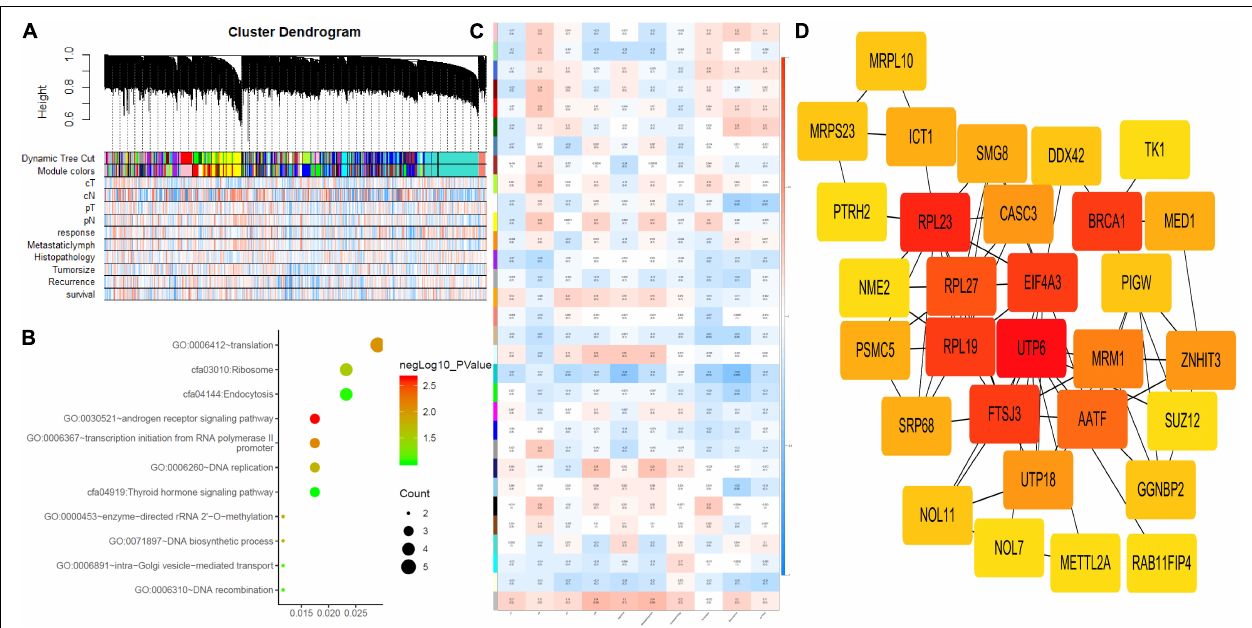
FIGURE 3 | Weighted gene co-expression network analysis and hub gene screened. (A) Dendrogram of all expressed genes in the top 25% of variance clustered based on a dissimilarity measure (1-TOM). (B) KEGG pathway and GO functional analysis of the pathways of genes in darkturquoise modules. (C) Heatmap of the correlation between module eigengenes and CRT-resistance. (D) PPI network of genes that had the highest score in the PPI degree in the darkturquoise module. The color intensity in each node was proportional to the degree of connectivity in the weighted gene co-expression network.